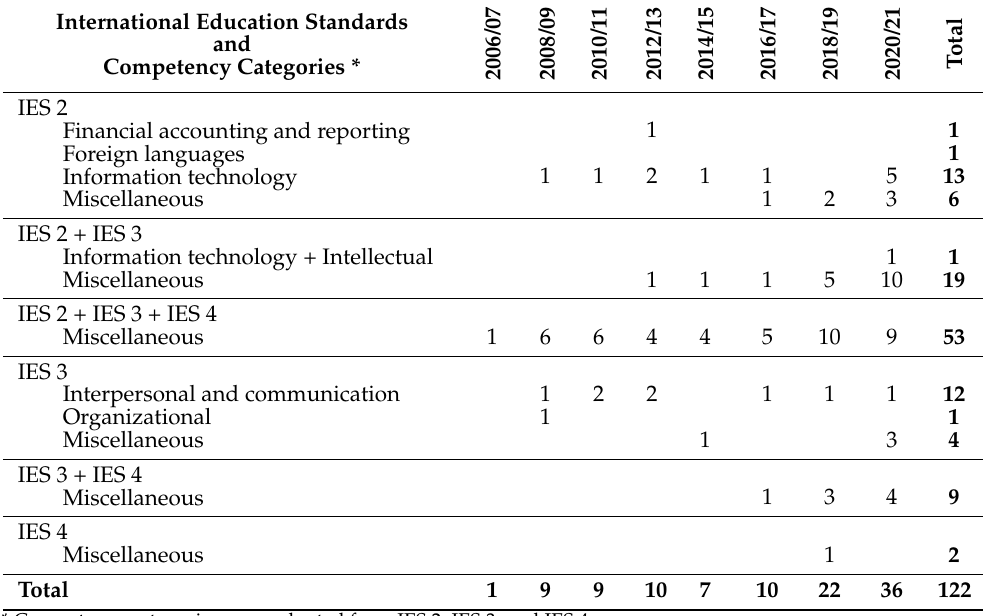
Table 7. Competency categorization of articles and their distribution over the